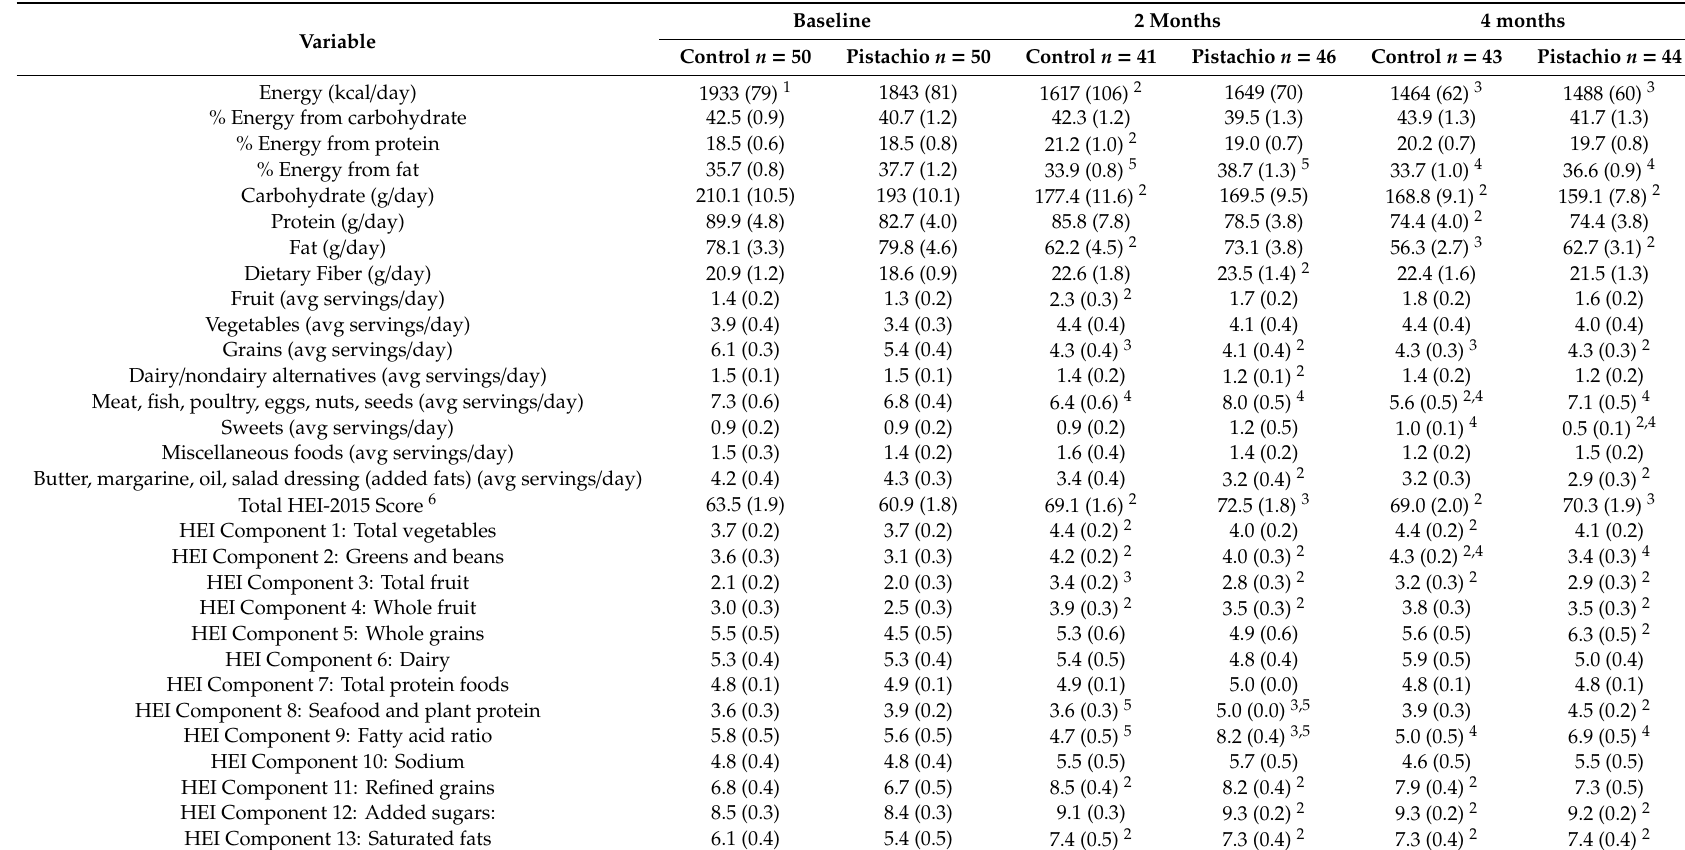
Table 5. Dietary intake of study participants in the weight loss